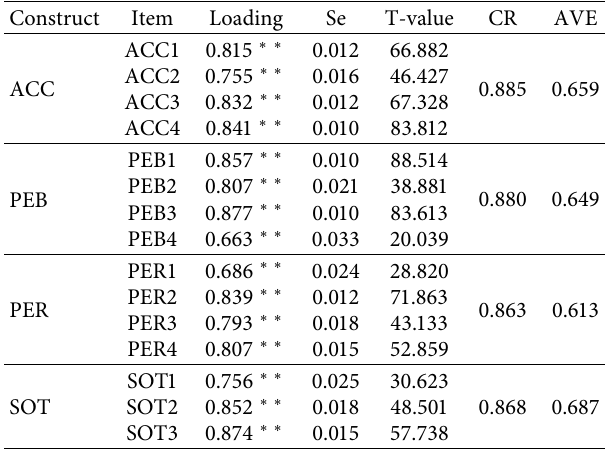
Table 5: Results of the confirmatory factor analysis (full sample). Construct